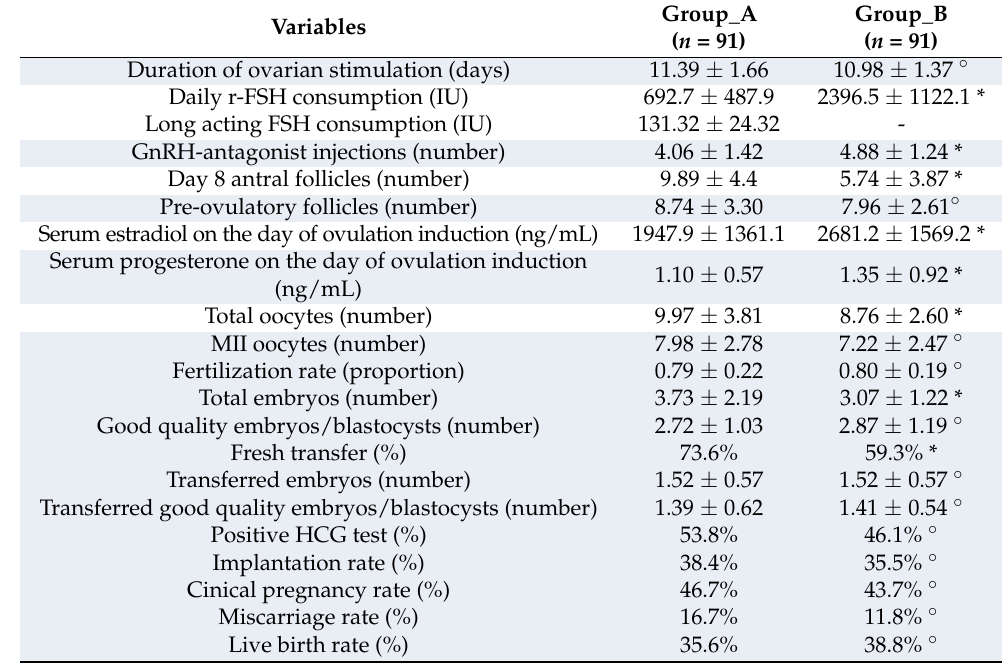
Table 2. Outcomes of the IVF cycles among groups (categoric and contiuous variables expressed as number/percentage or mean ± standard deviation,